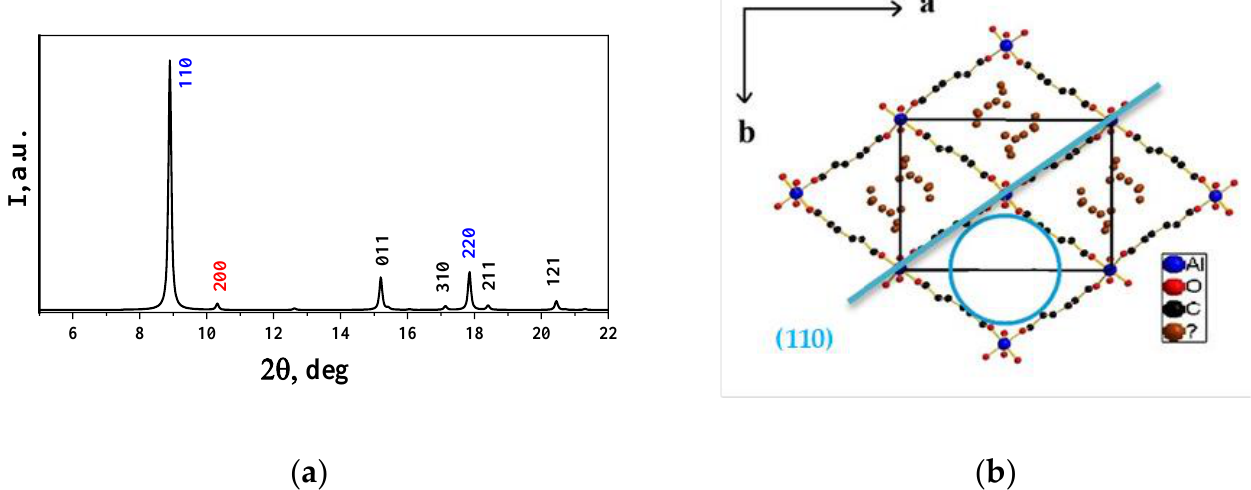
Figure 1. Structure I (sp.gr. Pnam, z = 4): theoretical diffraction pattern ( a ), structure projected onto the ( b ) XY